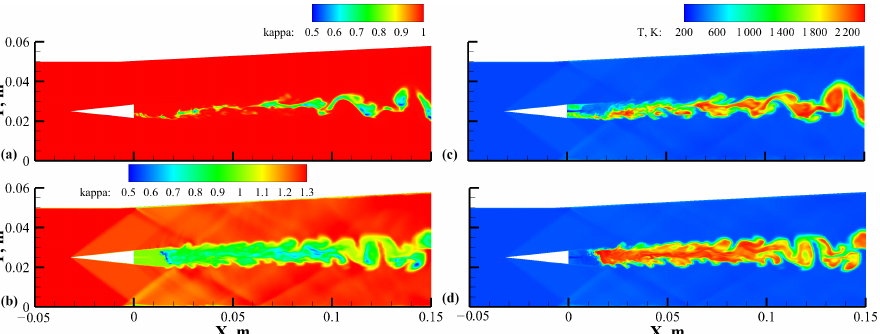
Figure 21. Contours of correction factors for the filtered reaction rate using the PaSR and PaSR-ISCM combustion models for ( a ) M0 and ( b ) M2; and temperature distributions using these two combustion models for ( c ) M0 and ( d ) M2.